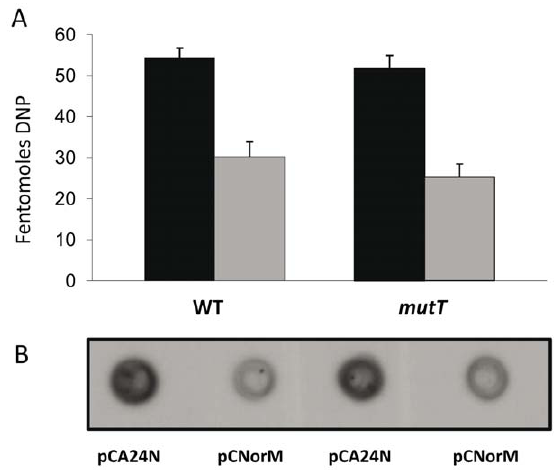
Figure 5. Protein carbonylation. Carbonylation is observed in the wild-type and mutT -derivative strains containing either the empty vector or the plasmid expressing norM , following treatment with 10mM H 2 O 2 for 15 min. A: Bar graph quantifying the protein carbonylation (femtomoles of DNP) in cells containing the empty vector pCA24N (black bars) or the norM -plasmid pCNorM (gray bars) in the wild-type (left bars) and mutT strains (right bars). The data are the mean values from four separate experiments and error bars represent one standard error. B: Representative blot showing the accumulation of protein carbonyl groups in H 2 O 2 challenged cells.